Question: In one sentence, what is this figure communicating?
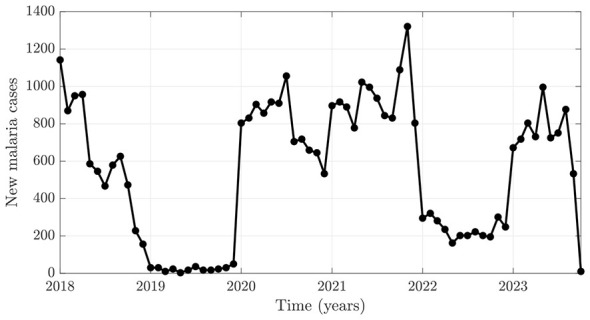
Answer: New monthly incidence data of Malaria in Keerom, from January 2018 to October 2023.